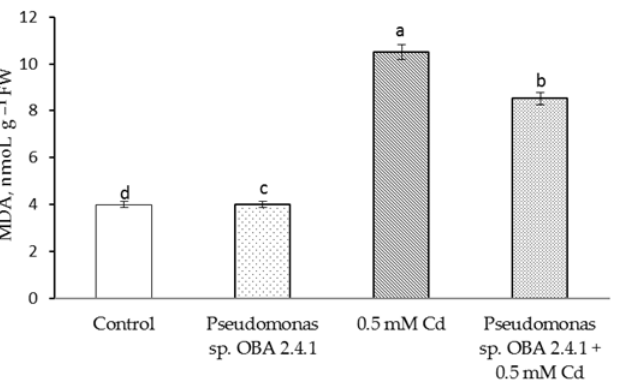
Figure 5. Effect of Pseudomonas sp. OBA 2.4.1 on the content of MDA in 7-day old pea seedlings under normal and Cd stress conditions. The bars indicate the mean values of three replicates ± SEM. Different lowercase letters indicate a significant difference between the means at the level of p < 0.05 (ANOVA, LSD test).